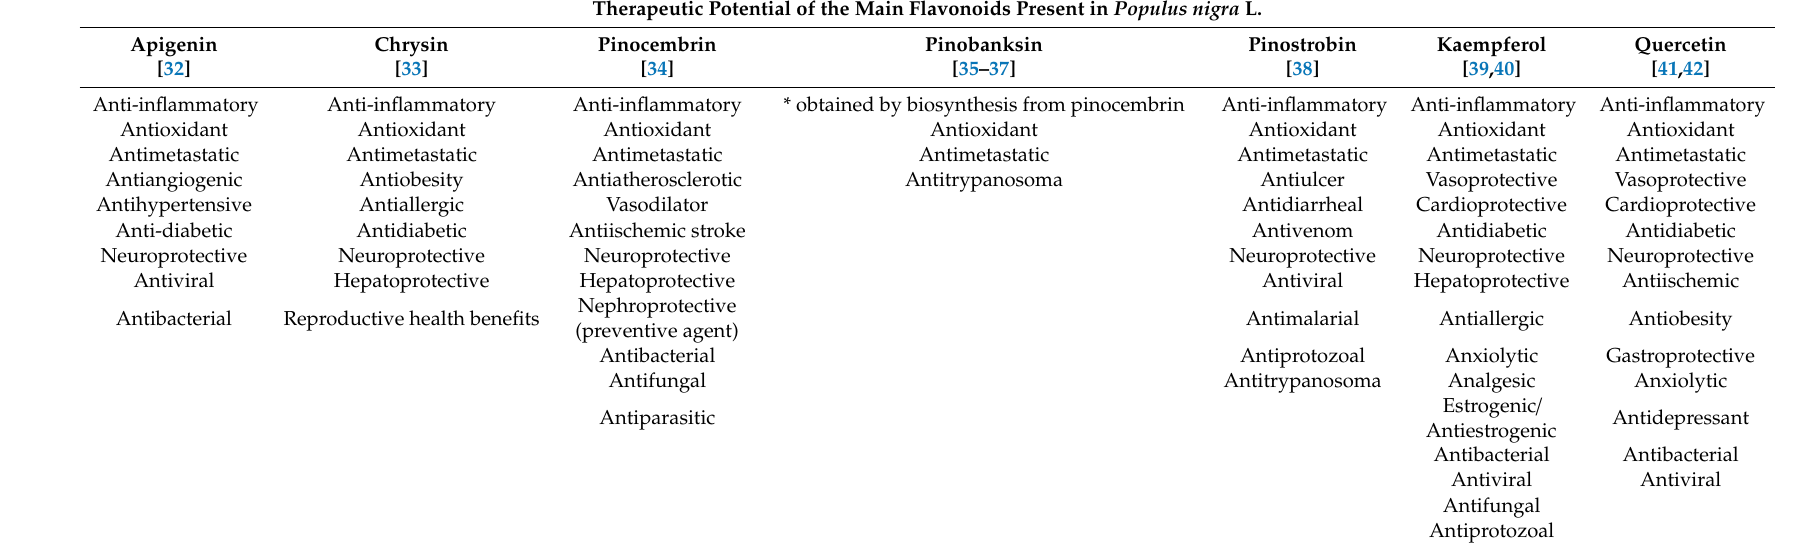
Table 1. Therapeutic potential of the main flavonoids in Populus nigra